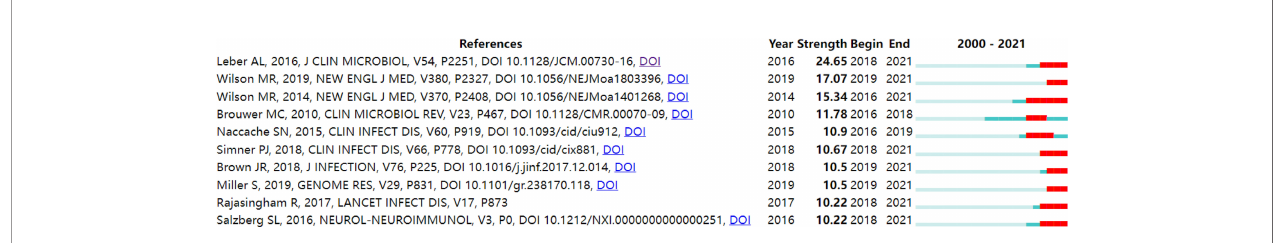
FIGURE 4 | Top 10 articles with citation burst of publications on pathogen detection in CNS infections (sorted by strengths of